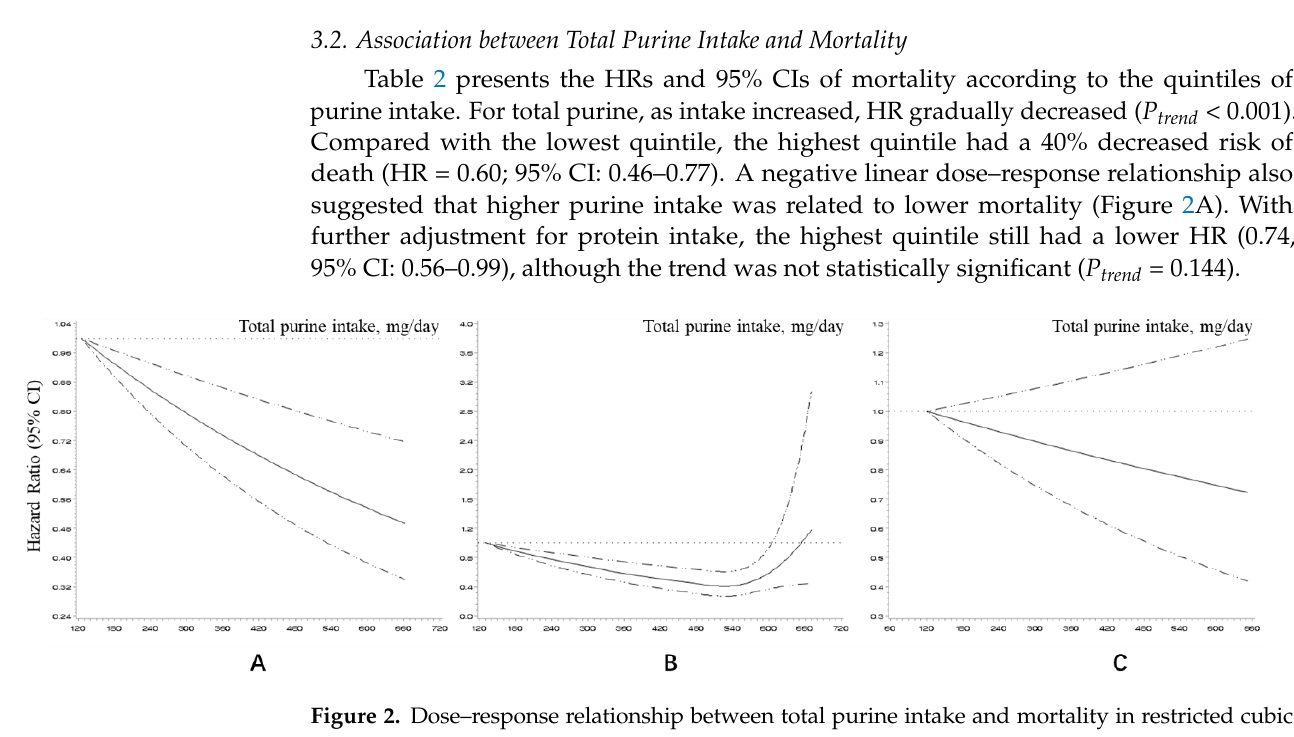
Figure 2. Dose–response relationship between total purine intake and mortality in restricted cubic splines after adjustment (for residence, income, education year, smoking status, drinking status, physical activity, BMI, energy intake, hypertension, and diabetes): ( A ) All participants; ( B ) Male; ( C ) Female.